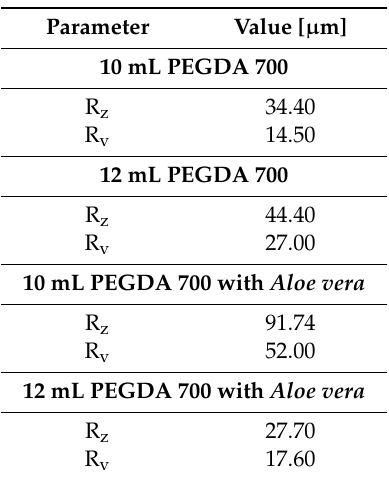
Table 6. Parameters of the surface roughness of analyzed hydrogels.